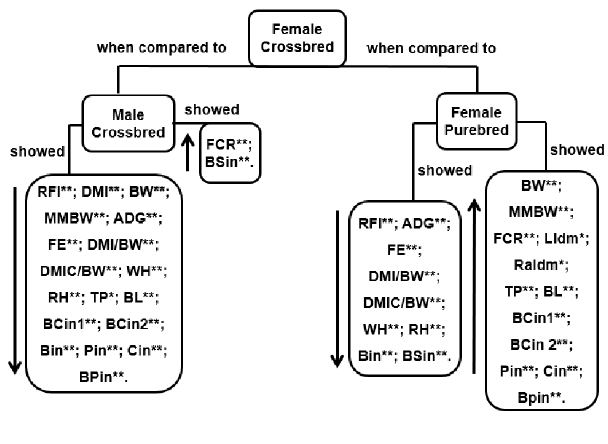
Figure 2. Comparison between means of male purebred x female purebred, male purebred x male crossbred. **P < 0.001; *P < 0.05. ADG = average daily gain; Ain = anamorphosis indice; BCin1 = body capacity indice 1; BCin2 = body capacity indice 2; Bin = body indice; BL = body length; BPin = body proportionality indice; BSin = body side indice; BW = body weight; Cin = compactness indice; DMI = dry matter intake; DMI/BW = dry matter intake/body weight; DMIC/BW = dry matter intake of concentrate/ body weight; FCR = feed conversion ratio; FE = feed efficiency; Hldm = height in Longissimus dorsi muscle; Lldm = length in Longissimus dorsi muscle; MMBW = metabolic body weight; Pin = proportionality indice; RAldm = ribeye area in longissimus dorsi muscle; RH = rump height; RTD = right testicular diameter; RTL = right testicle length; SC = scrotal circumference; SFT = subcutaneous fat thickness; TP = thoracic perimeter; WH = wither